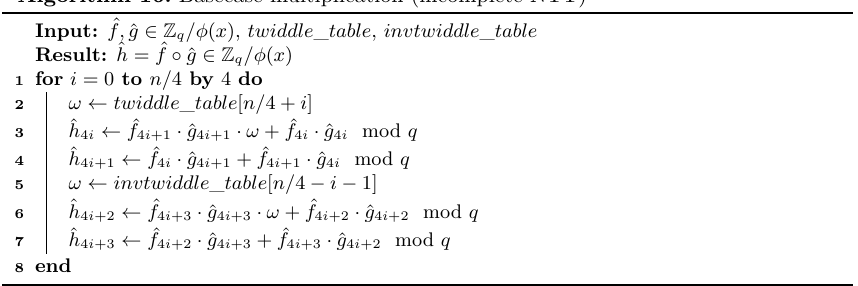
Algorithm 16: Basecase multiplication (incomplete